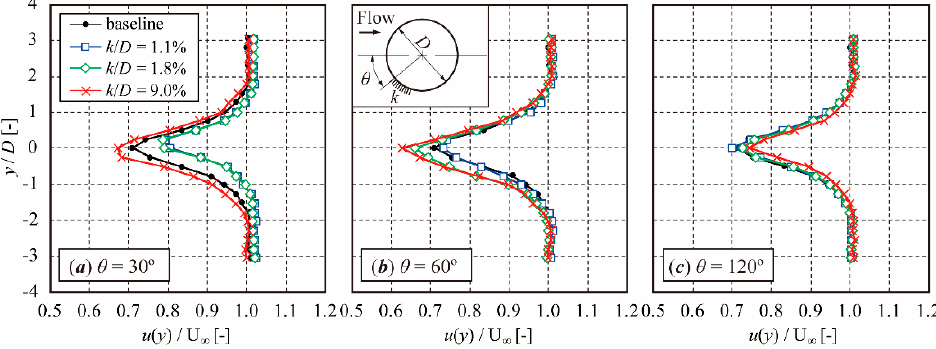
Figure 7. Comparison of mean velocity profiles in the wake for baseline and microfiber with relative length of k / D = 1.1%, 1.8%, and 9.0%: ( a ) θ = 30°; ( b ) θ = 60°; and ( c ) θ = 120°.